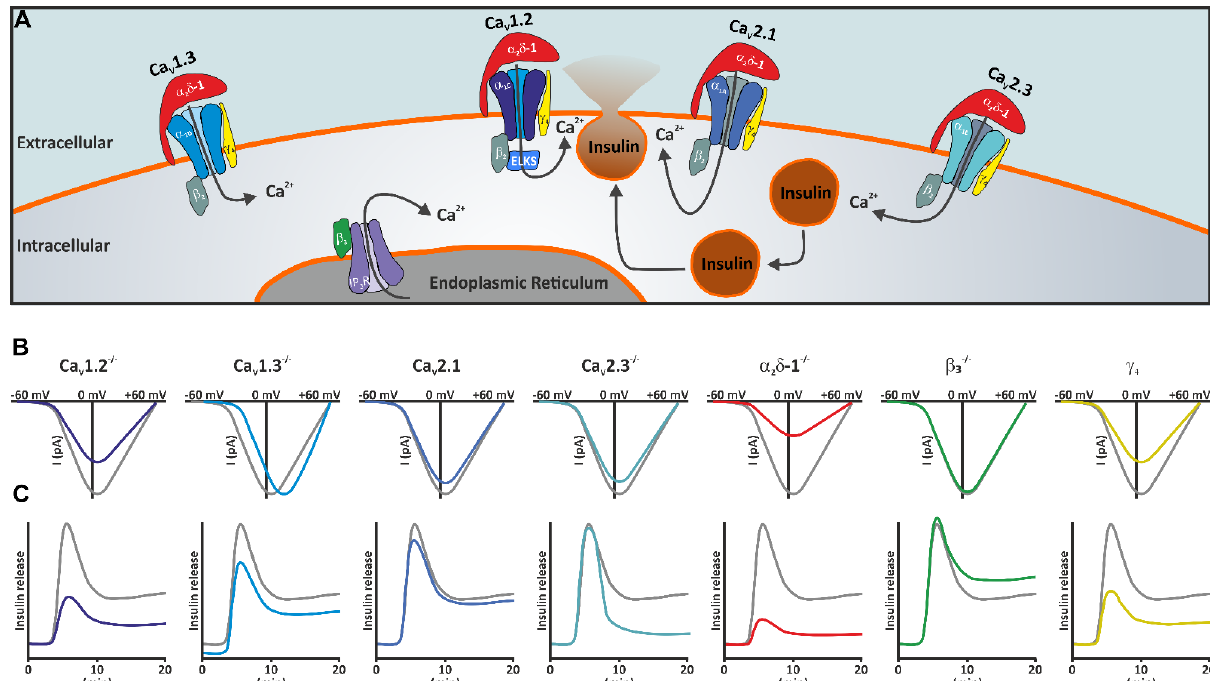
Figure 2. Role of the HVCC subunits on pancreatic β -cell insulin release. ( A ). Localization of the HVCC isoforms in pancreatic β -cells with respect to insulin vesicles. At least in mouse, Ca V 1.2 channels are coupled to vesicle release, while evidence suggests that in human β -cells, Ca V 2.1 takes the central role. The localization of Ca V 1.2 channels at the release sites is controlled by the interaction between β 2 subunit and ELKS. Ca V 2.3 channels are necessary for sustained insulin release, while the role of Ca V 1.3 is very controversial. β3 isoform does not come in complex with any HVCC but interacts with the IP 3 R. ( B ) Effect of genetic deletion or pharmacological block of each HVCC subunit isoform on total β -cell Ca 2+ current. Ca V 1.2 contribute with ~45% of the whole-cell Ca 2+ influx while Ca V 2.1 and Ca V 2.3 with ~20% each. Ca V 1.3 deletion only shifts the voltage dependence of activation. α 2 δ -1 deletion reduces all HVCC Ca 2+ currents by ~70% while γ 4 altered expression reduces only L-type Ca 2+ currents (~70%). ( C ) Role of the HVCC subunits on GIIS. Ca V 1.2 deletion has the strongest effect as it is coupled to insulin vesicle release. Ca V 1.3 deletion reduces insulin secretion at lower glucose concentration while lack of Ca V 2.3 Ca 2+ currents reduces second-phase GIIS. α 2 δ -1 deletion strongly reduces GIIS, while β 3 deletion increases insulin release. γ 4 reduced expression is expected to have similar effects as Ca V 1.2 deletion.